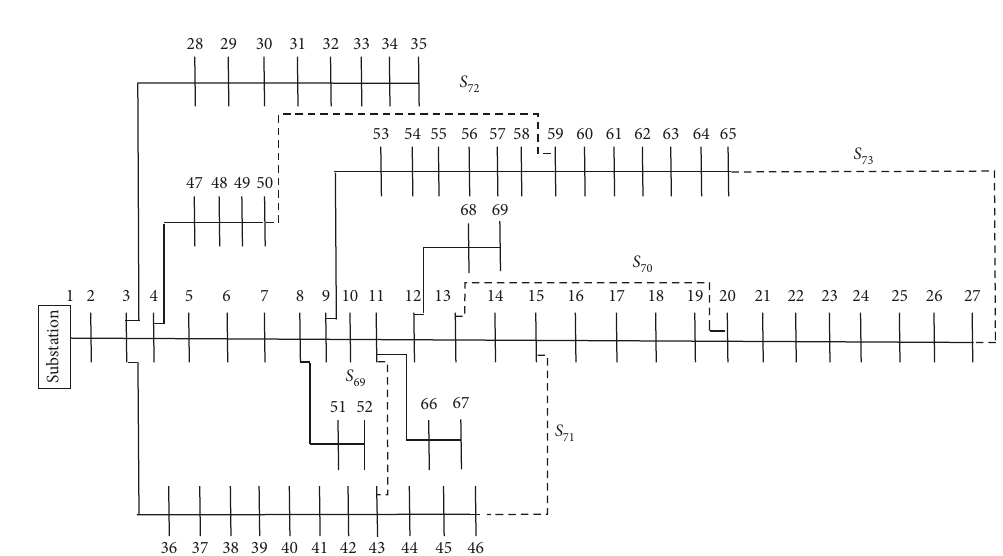
Figure 2: Single-line scheme for 69-bus RDS. Table 3: The typical parameters of the MBBO algorithm. Parameter Value